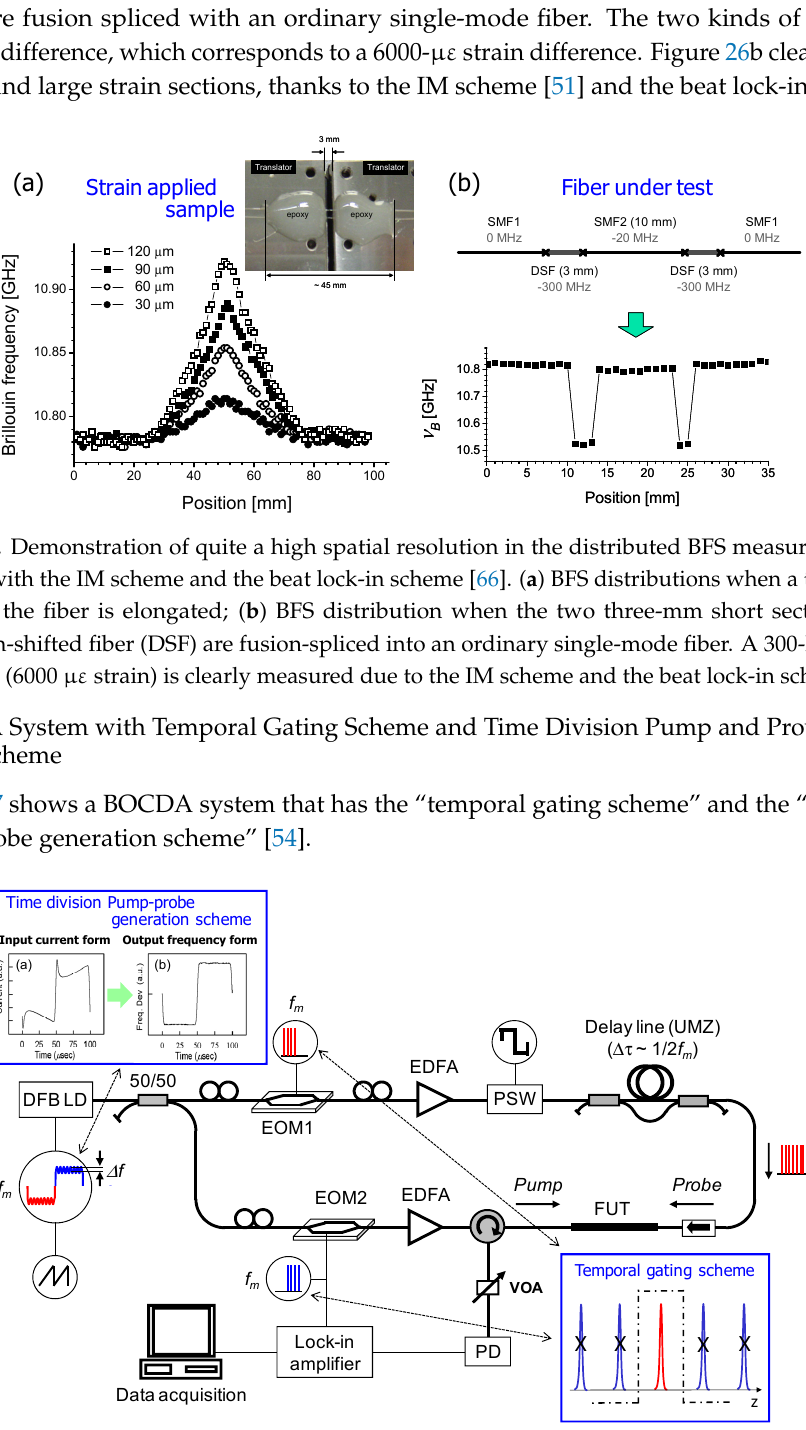
Figure 25. BGS distribution along the fiber obtained in experiments ( a , b ) and simulations ( c , d ), appropriate IM modulation.